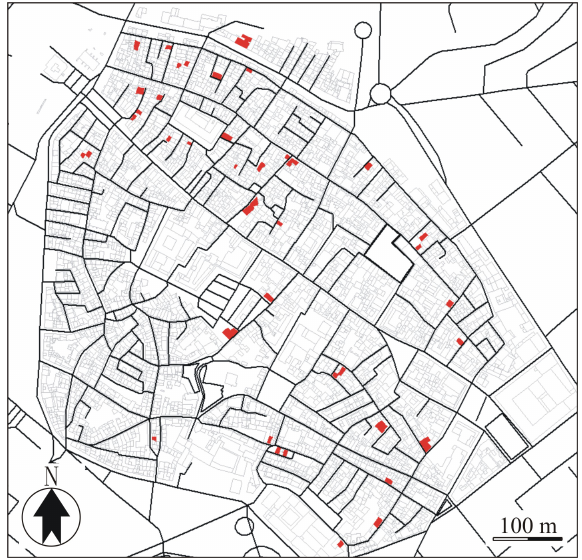
Figure 5. The buildings object of transformation according to the solution highlighted in Figure 4.